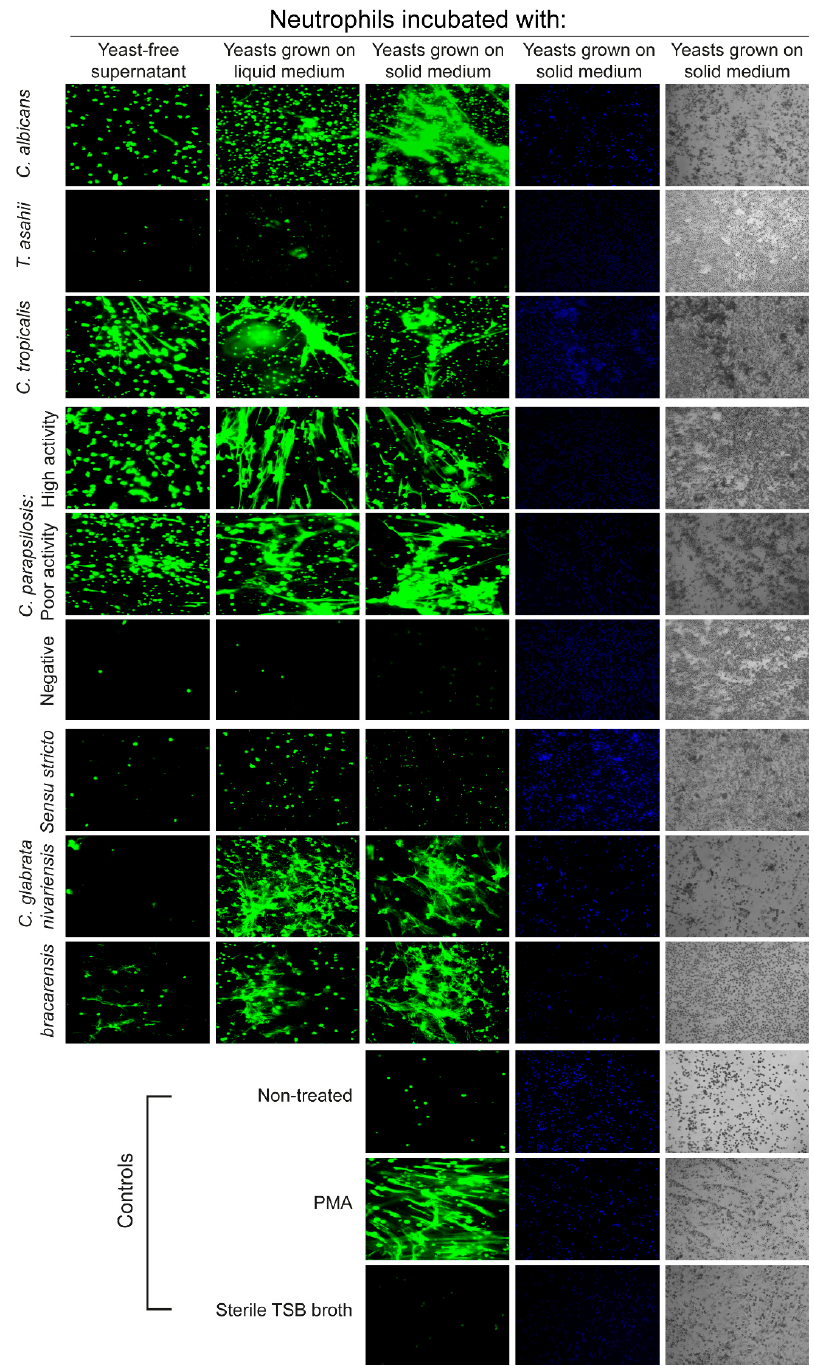
Figure 5. NETs formation correlates with expression of fungal phospholipases. Fluorescence microscopy images of non-treated neutrophils (NT), or treated with fungi and stained with Sytox to detect extracellular DNA after 180 min of treatment are shown. The treatments were: PMA (40 nM); yeast of C. albicans , C. tropicalis , C. glabrata sensu stricto , C. bracarensis , C. nivariensis ; strains of C. parapsilosis with high, poor, or negative phospholipase activity; or phospholipase deficient T. asahii isolates grown on liquid or solid medium (MOI 0.2:1), fungi culture media filtered through 0.22 µ M (1 µ g/mL), sterile Trypticase Soy Broth (TSB) or left untreated. Additionally, bright field images and nuclei stained with Hoechst (blue) for the yeast grown in solid medium and controls are shown. All experiments were made in triplicate from two different donors each